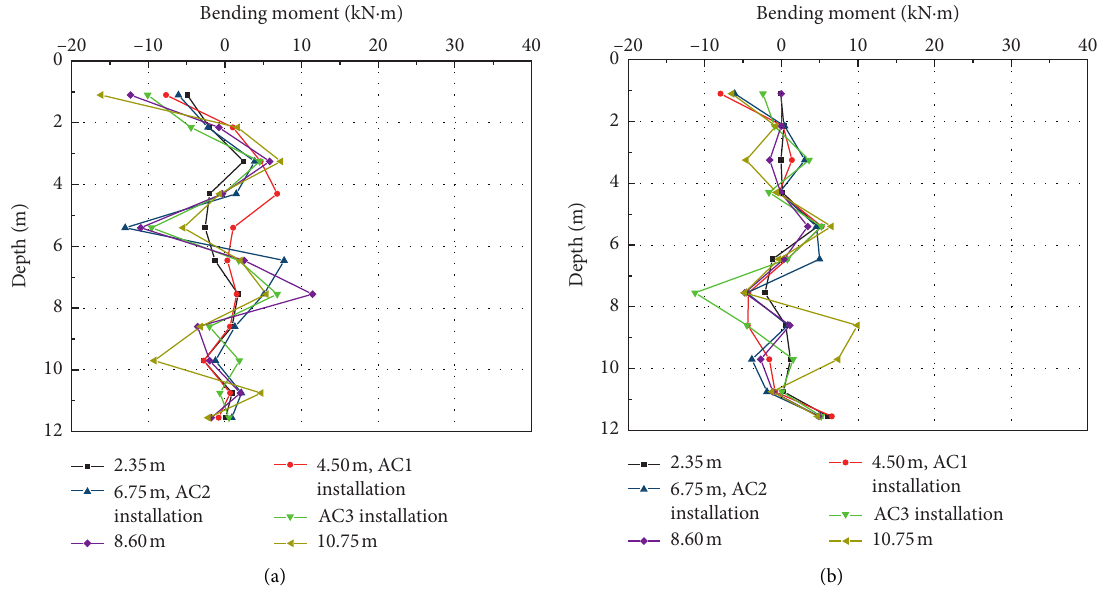
Figure 5: Bending moment of piles during the first-order excavation. (a) Test pile 1. (b) Test pile 2.